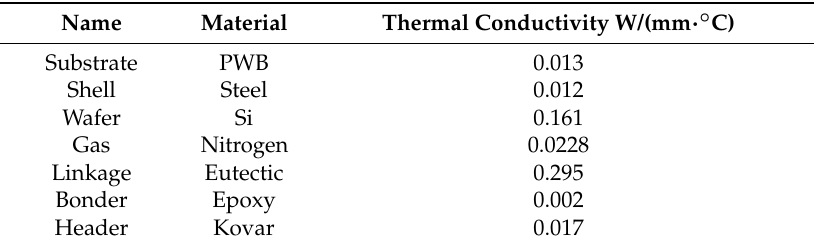
Table 1. SiP structural materials and characteristics.